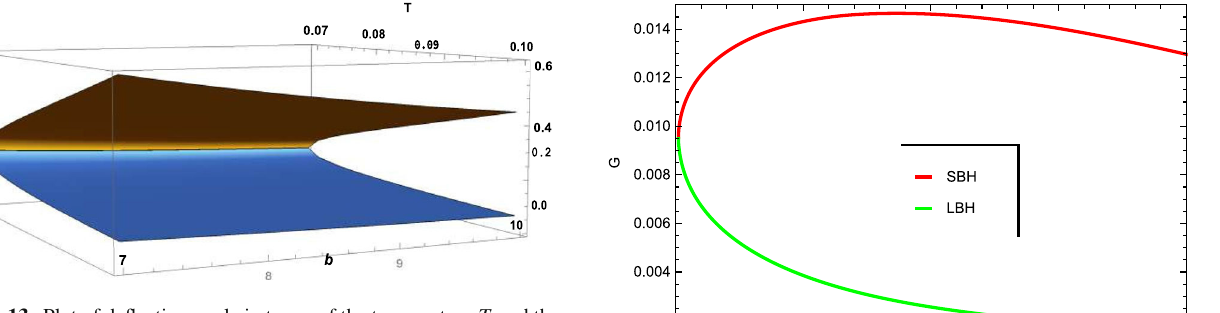
Fig. 13 Plot of deflection angle in terms of the temperature T and the impact parameter b for P = 0 . 04 and (cid:20) = 0 . 9 solid and dashed curves show the critical points. The second